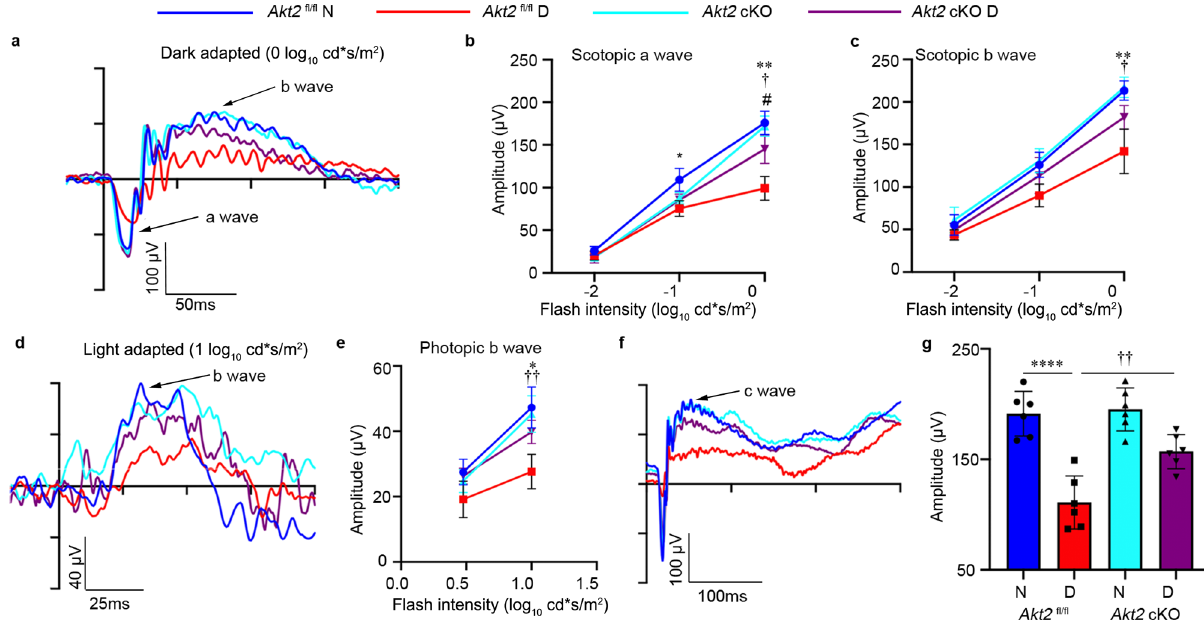
Fig.1|Electroretinography(ERG)suggeststhatRPE-speci fi c Akt2 cKOpartially rescues diabetes-induced disruption of retinal function (4 month duration of diabetes).a RepresentativescotopicERGa-andb-waveforms,showingresponseto a 0 log 10 cd·s/m 2 stimulus luminance after overnight dark adaptation. Scotopic ( b ) a-wave and ( c ) b-wave amplitudes were decreased in diabetic Akt2 fl / fl mice com- paredtonondiabeticcontrols.ThesechangeswerepartiallyrescuedinRPE-speci fi c Akt2 cKO diabetic mice. d Representative photopic ERG waveforms response to a 1 log 10 cd·s/m 2 stimulus luminance after light adaptation. e Induction of diabetes decreased the photopic b-wave amplitude in diabetic Akt2 fl / fl mice, which was res- cuedinRPE-speci fi c Akt2 cKOdiabeticmice. f RepresentativeERGc-waveforms.(g) Diabetes decreasedthe c-wave amplitude in Akt2 fl / fl mice compared to nondiabetic animals,whichwaspartiallymitigatedin Akt2 cKOdiabeticmice.In( b , c , e , g ), n =6 mice for each group, the data are expressed as mean±SD. * p <0.05; ** p <0.01;